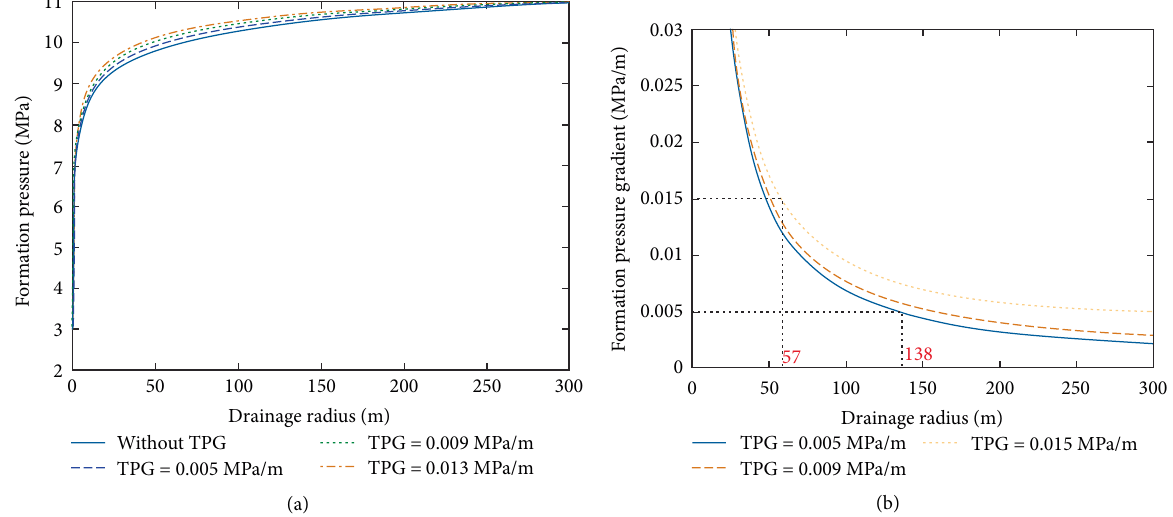
Figure 6: Effect of TPG on formation pressure and formation pressure gradient. (a) Relationship between formation pressure and drainage radius under different TPG. (b) Relationship between formation pressure gradient and drainage radius under different TPG.